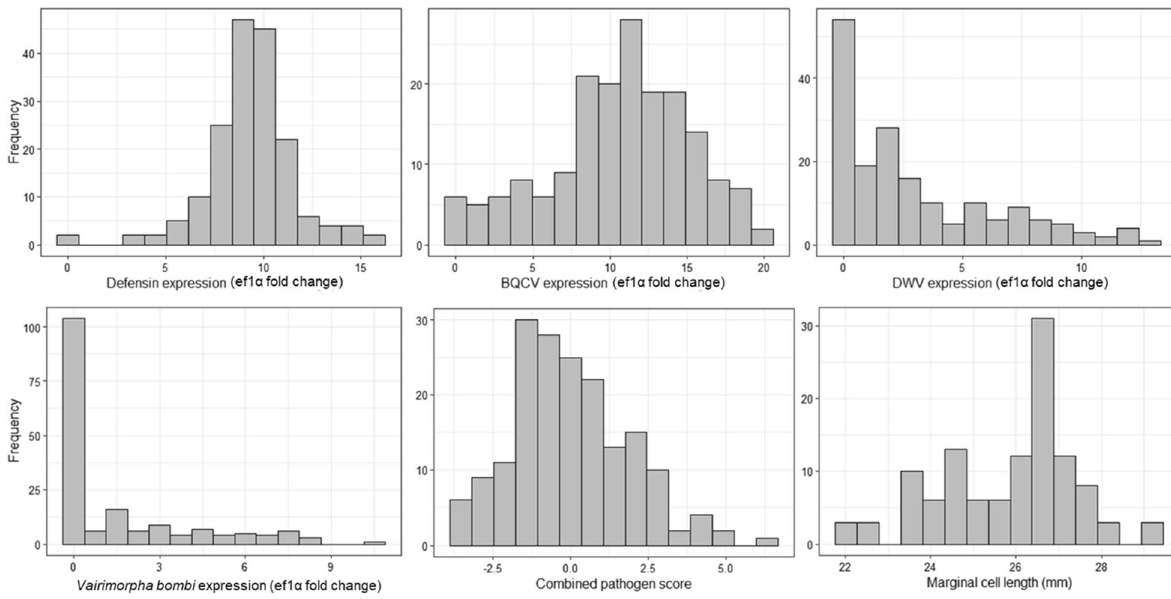
Figure 2. Histograms of the six response variables evaluated in Bombus impatiens workers across 38 counties in Pennsylvania: Defensin (top left), black queen cell virus (BQCV) (top center), deformed wing virus (DWV) (top right), Vairimorpha (bottom left), combined pathogens (bottom center; scaled to zero) and marginal cell length (bottom right). Shown on the X-axes are normalized expression values for DWV, BQCV, Vairimorpha and defensin, normalized to the amount of EF-1α in each